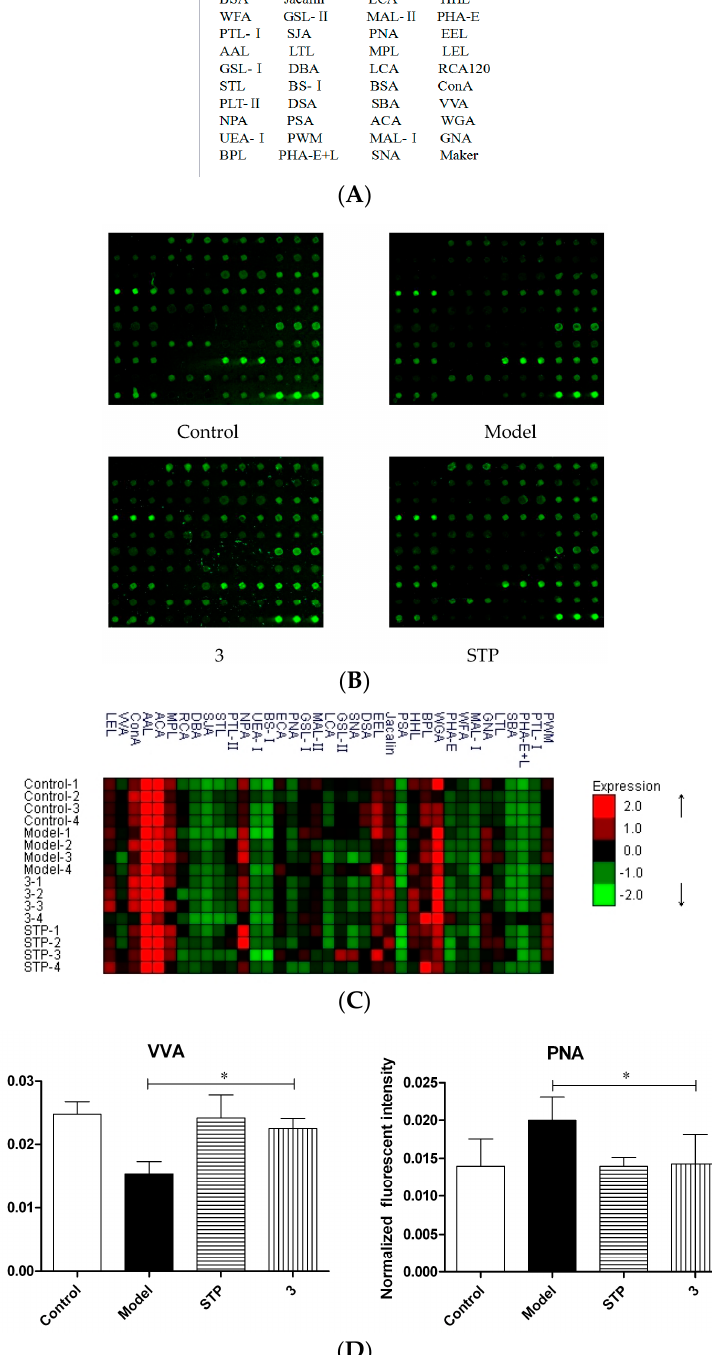
Figure 2. Effect of compound 3 and STP on glycosylation changes in chronic epilepsy in mice by using glycomics techniques. ( A ) the selected 37 lectins; ( B ) the image of the lectin microarrays, which included a total of 16 brains samples; ( C ) Unsupervised average linkage hierarchical cluster analysis of the lectin microarray responses to brain samples. The each brain sample of the control, model, 3 and STP were listed in columns, and the selected 37 lectins were listed in rows. The color and intensity of each square indicated expression levels with respect to the other data in the row. Red, high; black, medium; green, low; ( D ) two lectins (VVA and PNA) revealed differences between control and model group induced by sc PTZ. The results are presented as means ± SEM ( n = 4); * p < 0.05, compared with model group.